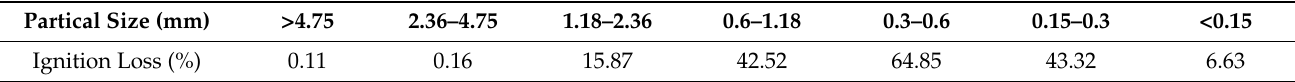
Table 2. Ignition loss of CS with different particle sizes.